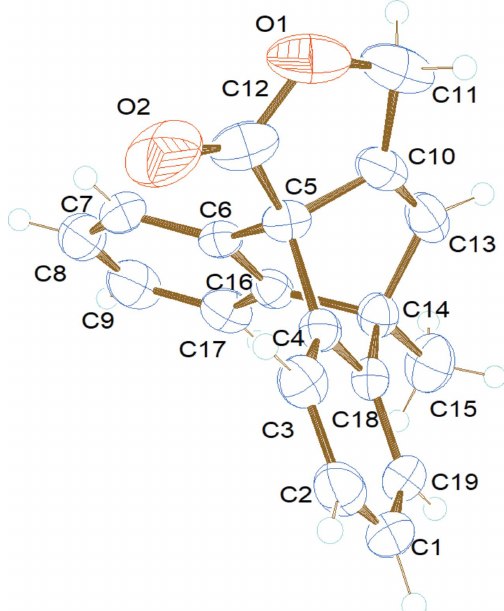
related molecules (Table 1, Fig. 2). A further C—H (cid:3) (cid:3) (cid:3) (cid:2) interaction links the inversion-related molecules along the b- axis direction (Figs. 2 and 3).